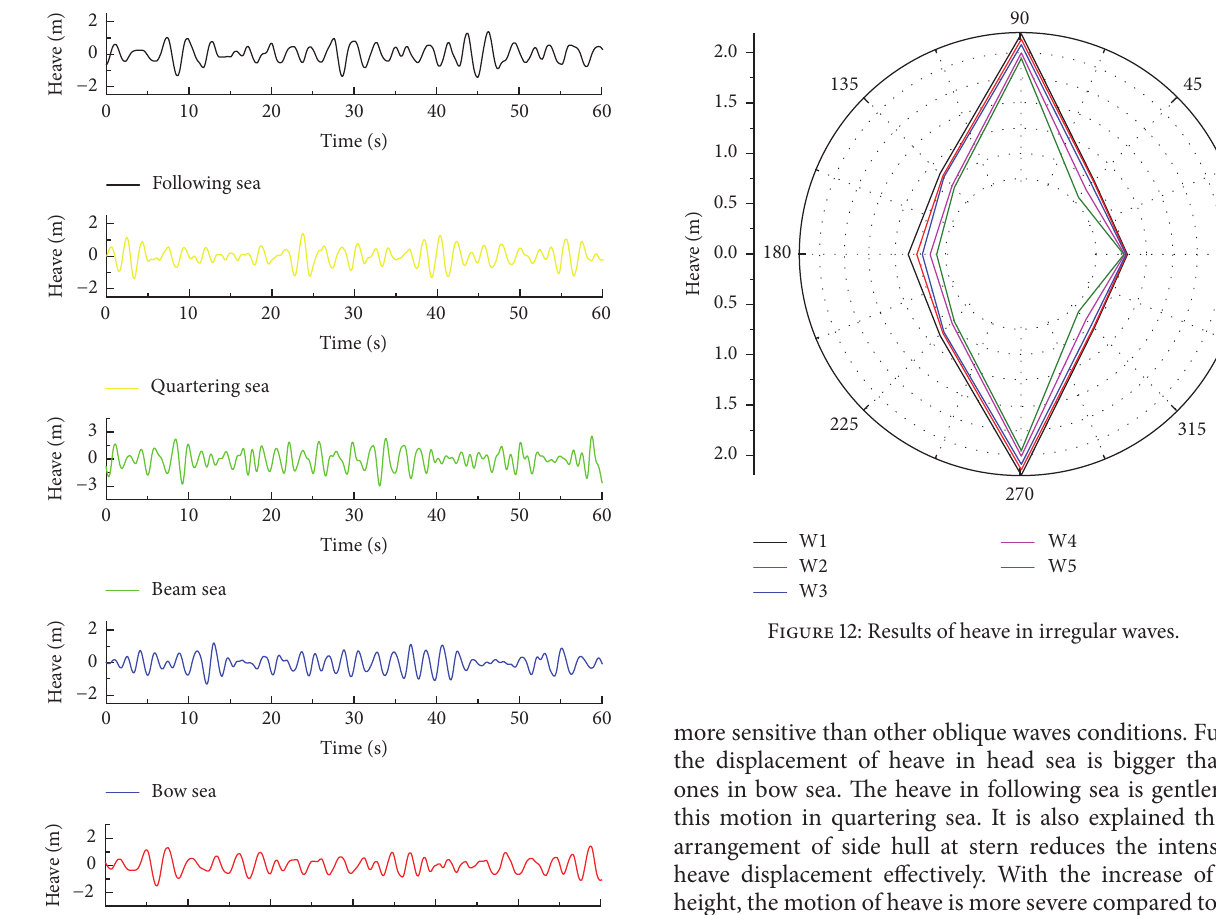
more sensitive than other oblique waves conditions.